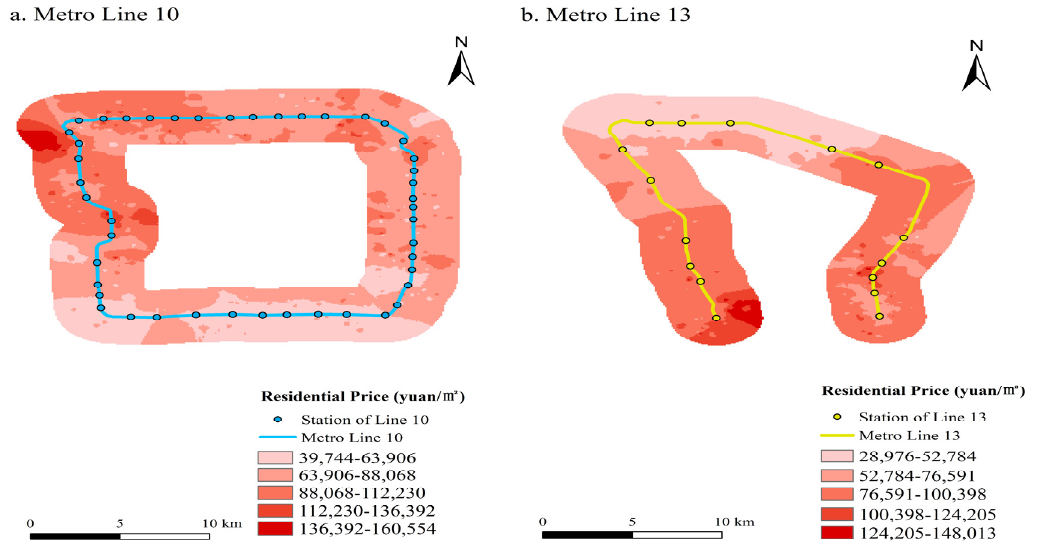
Figure 5. Residential price interpolation map of Metro Line 10 and Line 13.